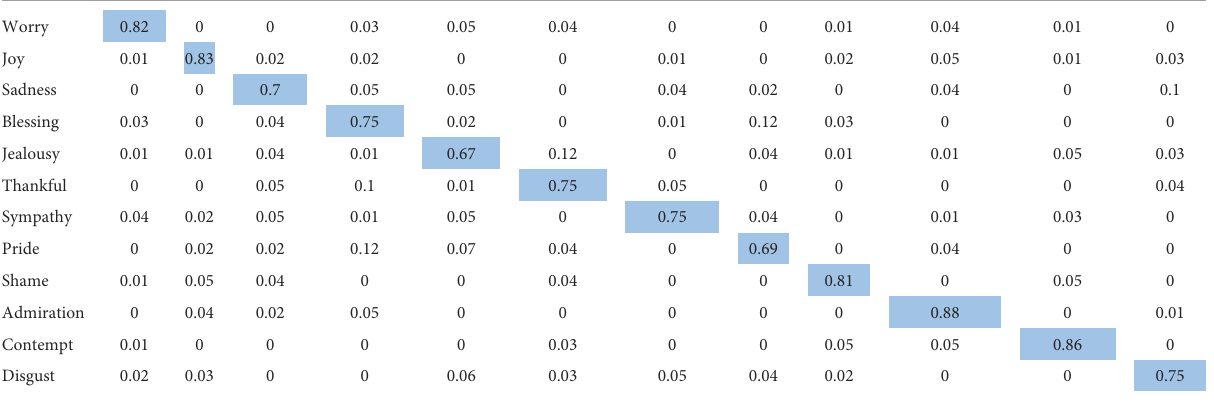
TABLE 7 12-Class sentiment classification confusion matrix (Flat-OCC +